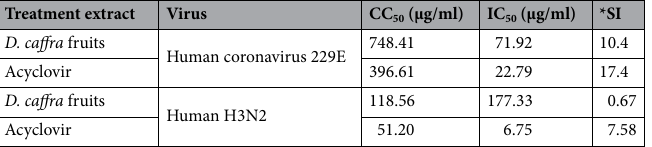
Treatment extract